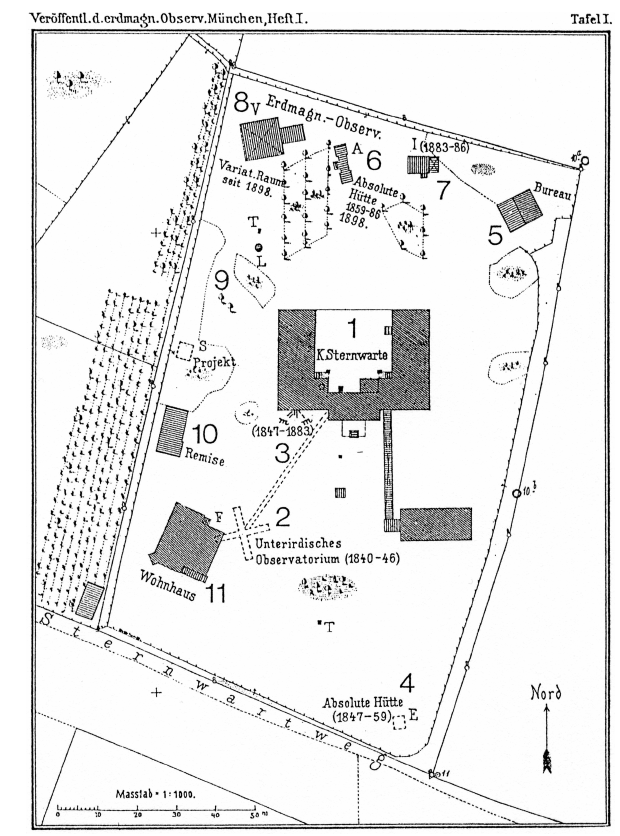
Figure 10. Map of the astronomical observatory site from 1904. (1) Main building. (2) Partially subsurface observatory from 1840 to 1846. (3) Position of the instruments for the measurements of D , I and H between 1847 and 1883. (4) Place for absolute mea- surements between 1847 and 1859. (5) Office. (6) Building for ab- solute measurements after 1859. (7) Laboratory. (8) Laboratory for the measurement of temporal variations. (10) Coach house and tool shed. (11) Residence of the new director, Prof. Dr. Hugo von Seel-